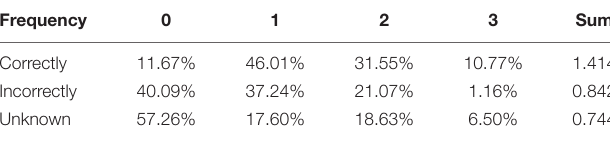
TABLE 1 | Results of respondents’ answering of financial